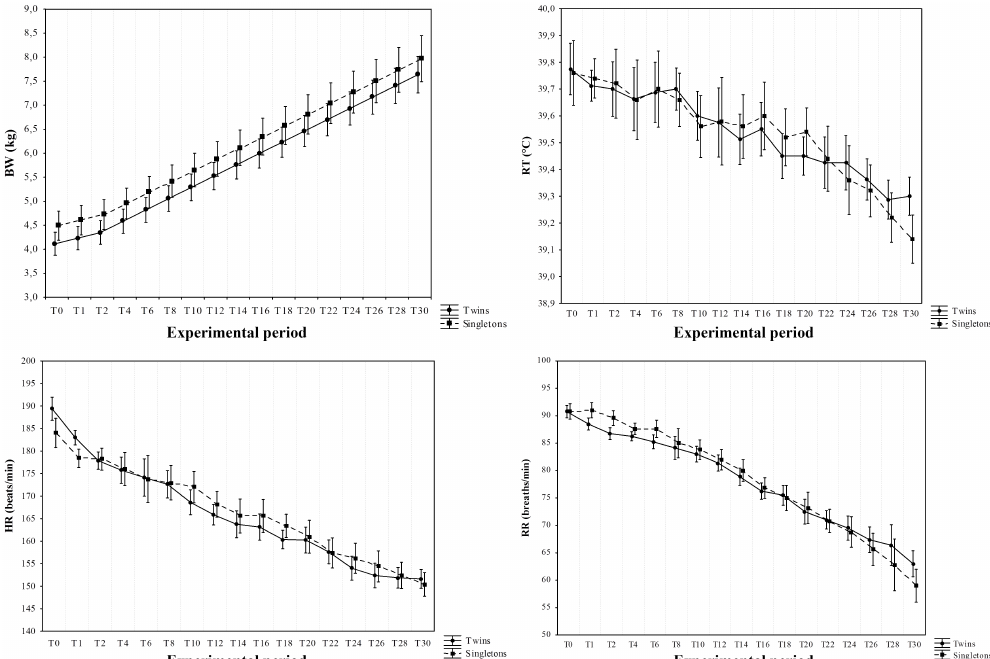
Figure 1. Mean values of body weight (BW), rectal temperature (RT), heart rate (HR) and respiratory rate (RR) obtained from singleton and twin lambs during the first month of life. Vertical bars denote ± 95% confidence intervals.